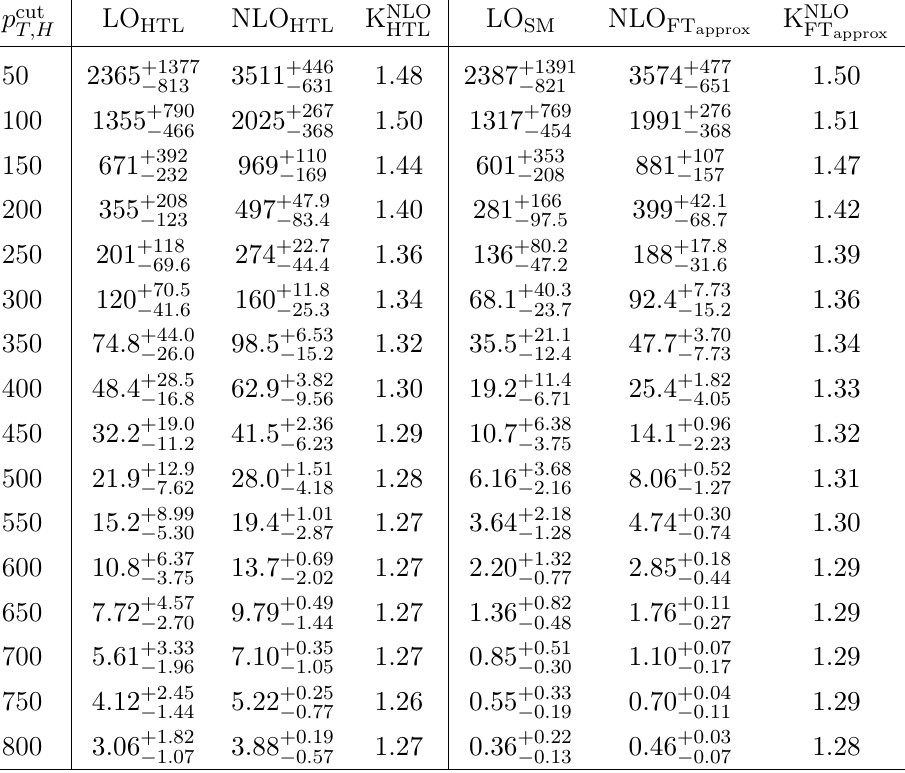
Table 4 . Integrated cross sections in fb depending on p cut for H + 2 jets production at the LHC with Uncertainties correspond to the envelope of 7-point scale variations. We require p T ; j p T ; j > 30 GeV 2